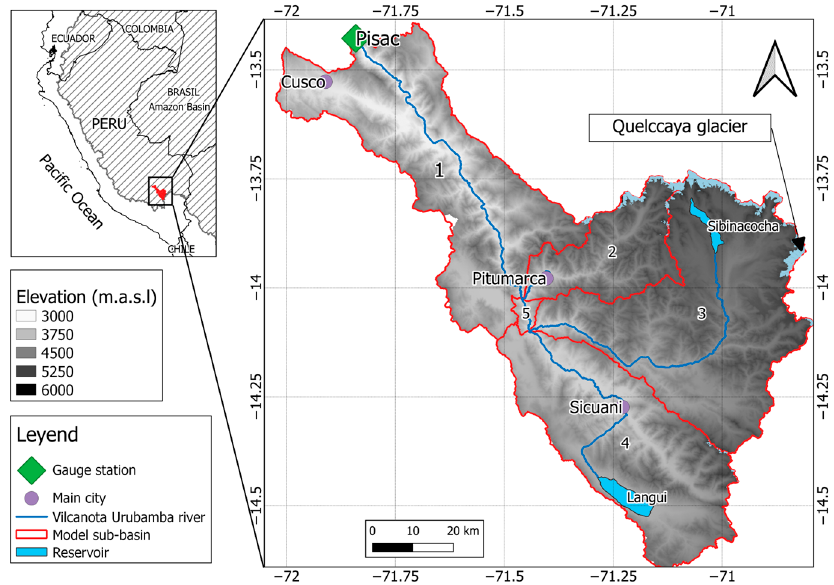
Figure 1. Study area showing the location of the hydrometric station, towns, rivers, and reservoirs.